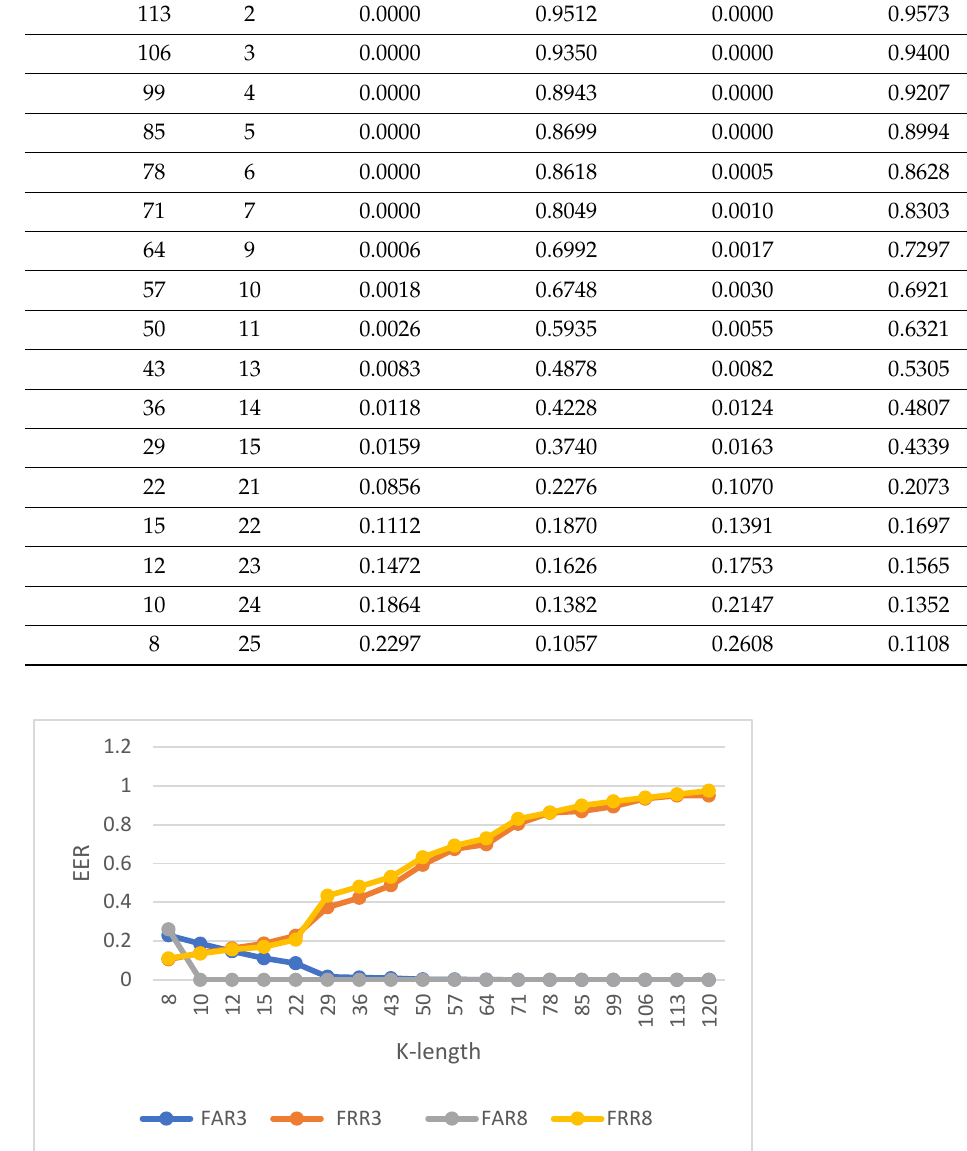
Table 3. The results of the first experiment with the Touchalytics dataset. Three Enrollment Samples